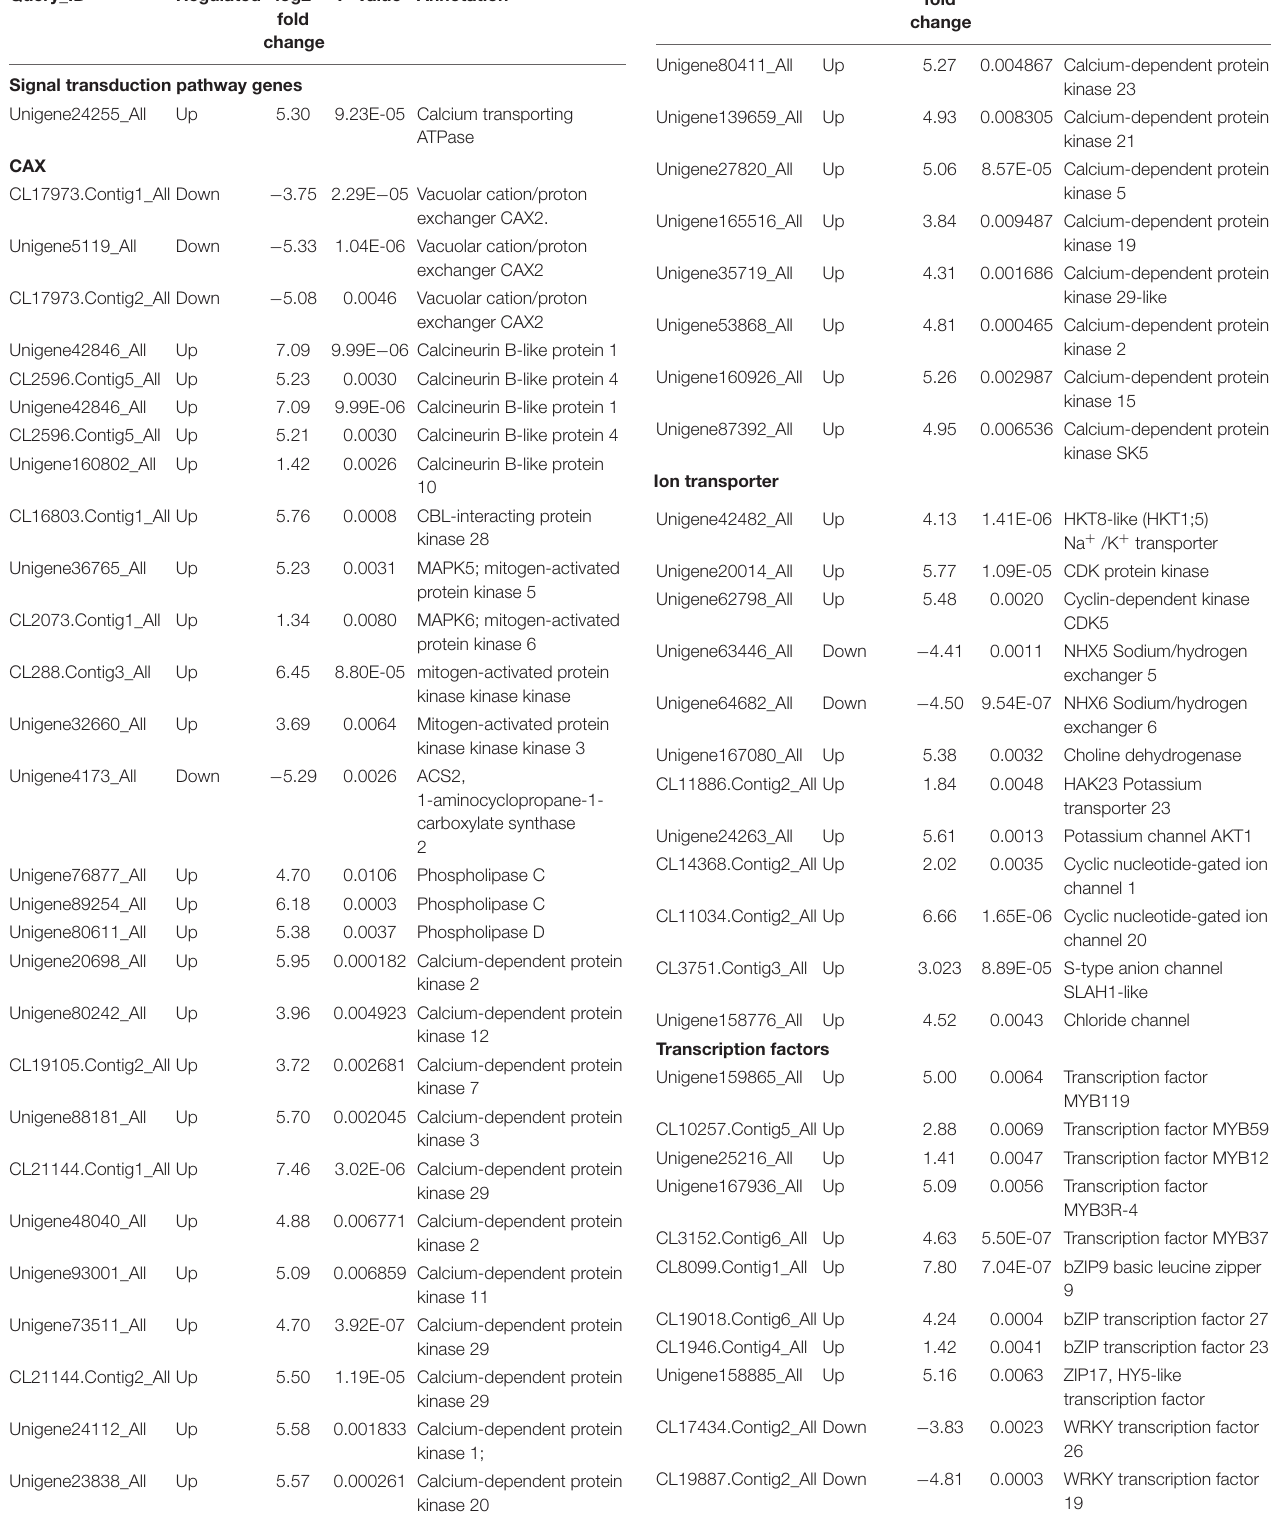
TABLE 3 | Fold changes of differentially expressed genes under salt stresses in the roots of P. nuttalliana.